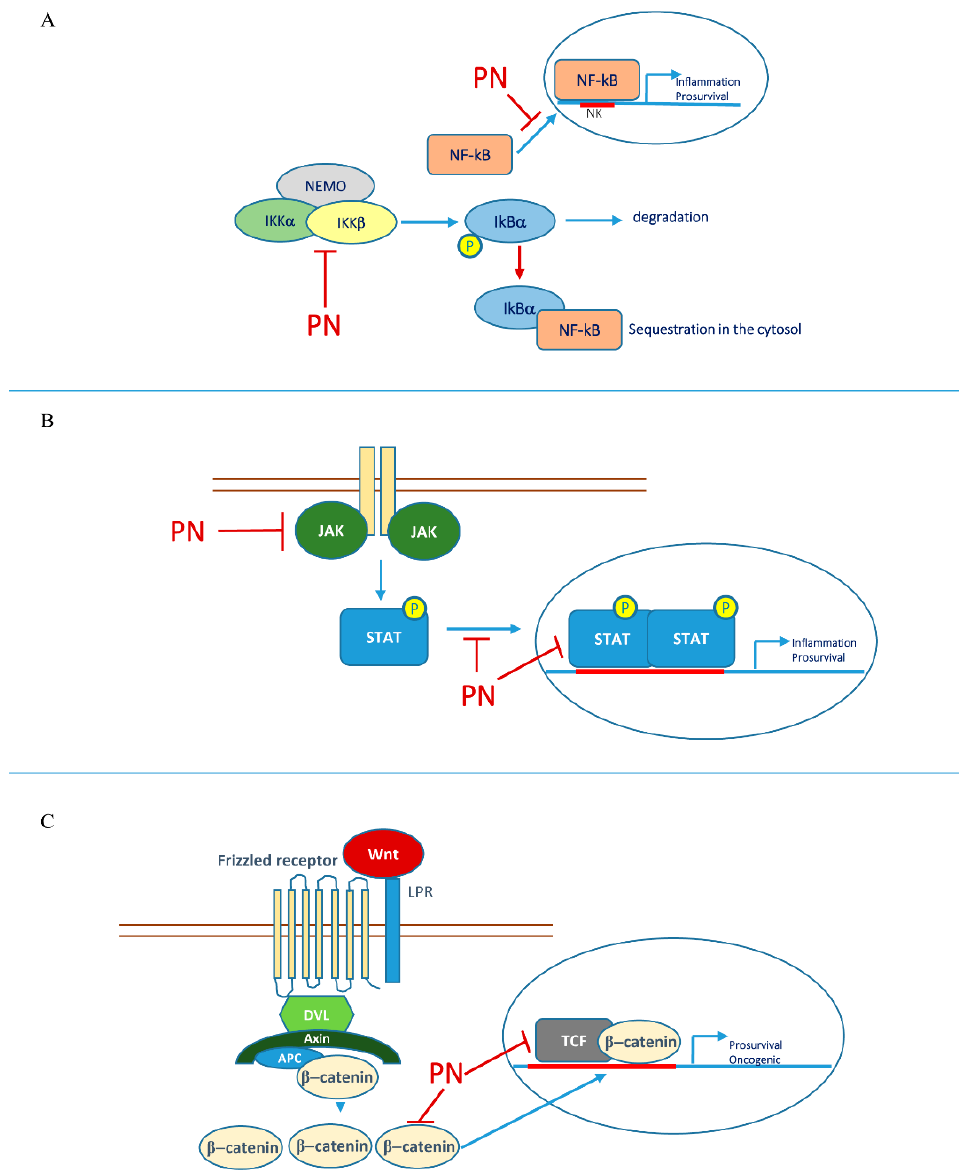
Figure 2. Effects of PN on prosurvival/oncogenic transcriptional factors and relative signaling: ( A ) ( A ) NF- κ B; ( B ) JAK/STAT; ( C ) β NF-KB; ( B ) JAK/STAT; ( C ) β-catenin.